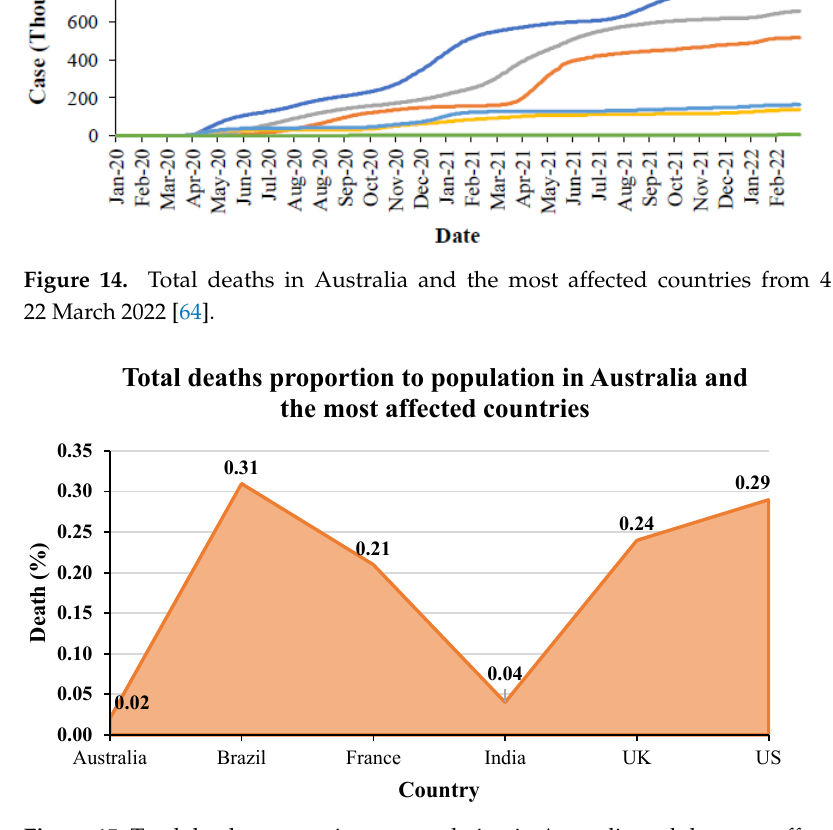
Figure 15. Total deaths proportion to population in Australia and the most affected countries from the first emergence to March 2022.